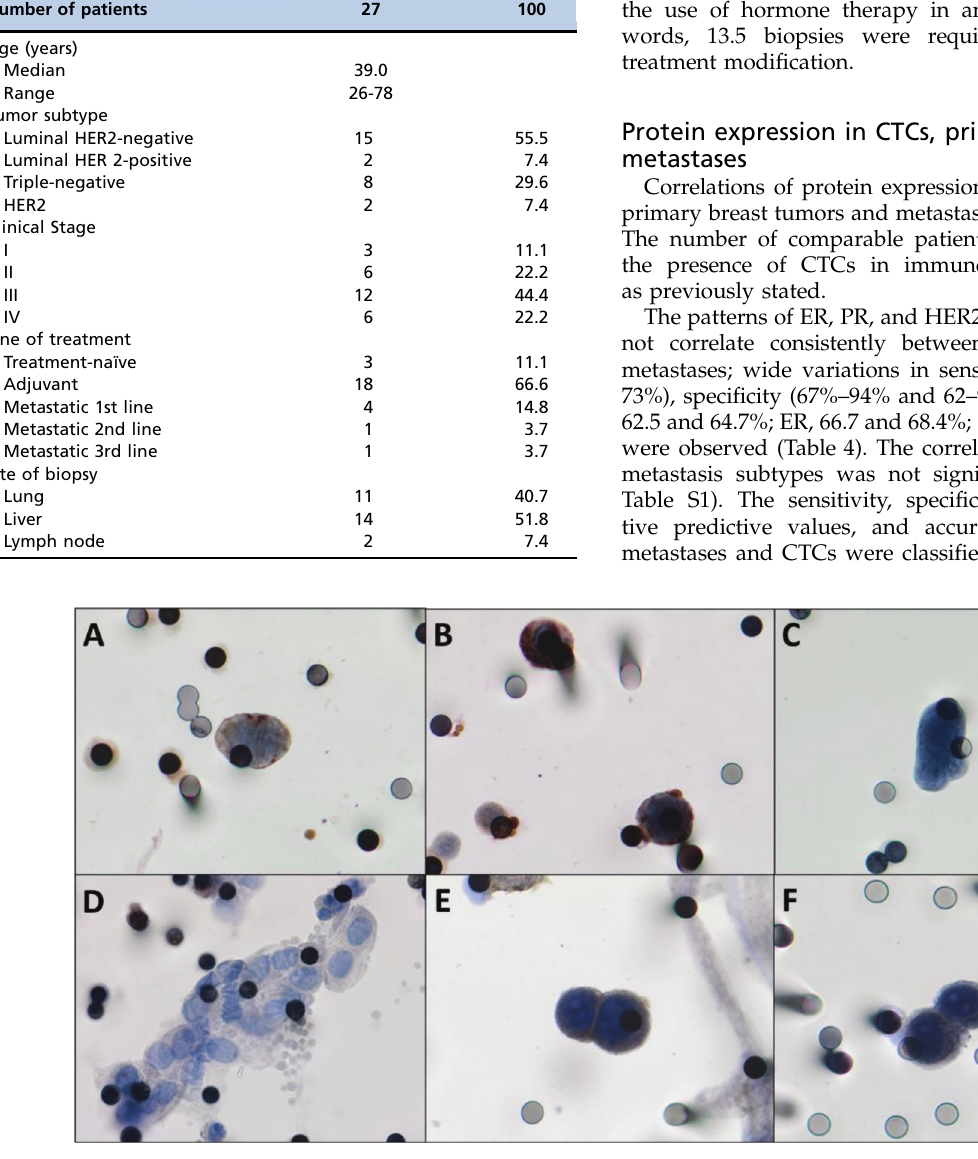
Figure 2 - A,B) Photomicrographs of CTCs isolated from breast cancer patients immunostained for estrogen receptor and progesterone receptor, respectively (counterstaining with DAB). C) CTCs visualized by hematoxylin, without any antibody staining. D) One CTM was observed in the filtered blood from a patient with breast cancer. E,F) Positive controls, MCF-7 cells ‘‘ spiked ’’ in healthy blood and stained for estrogen receptor and progesterone receptor respectively. Both images were taken at 400 (cid:1) magnification using a light microscope (Research System Microscope BX61; Olympus, Tokyo, Japan) coupled to a digital camera (SC100; Olympus). Abbreviations: CTCs, circulating tumor cells; DAB, 3,3 0 -daminobenzidine; CTM, circulating tumor